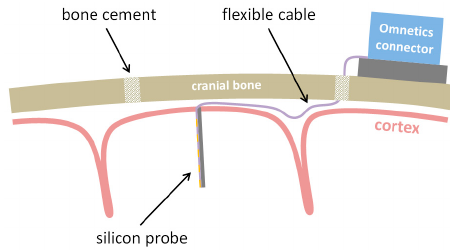
Figure 1. Schematic of a free-floating implantation of an intracortical silicon-stiffened neural probe to reduce the mechanical coupling between the cortex and the skull-fixed connector during brain micromotion [15].